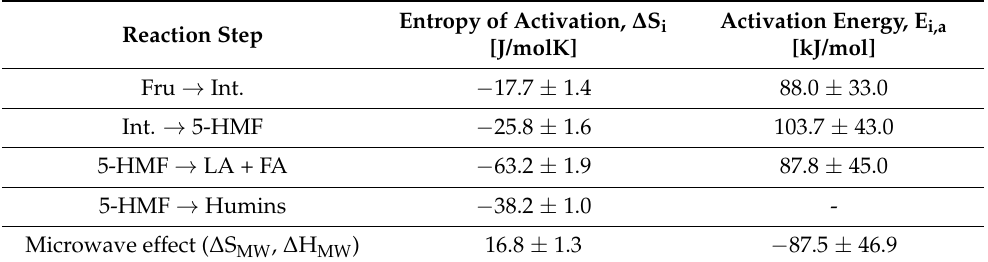
Table 6. Entropy change ∆ S i and apparent activation energy E i,a, including 95% highest posterior density (HPD) intervals. obtained by Bayesian estimation against the CH dataset for fructose dehydration over MIL-101(Cr)-SO 3 H(3).